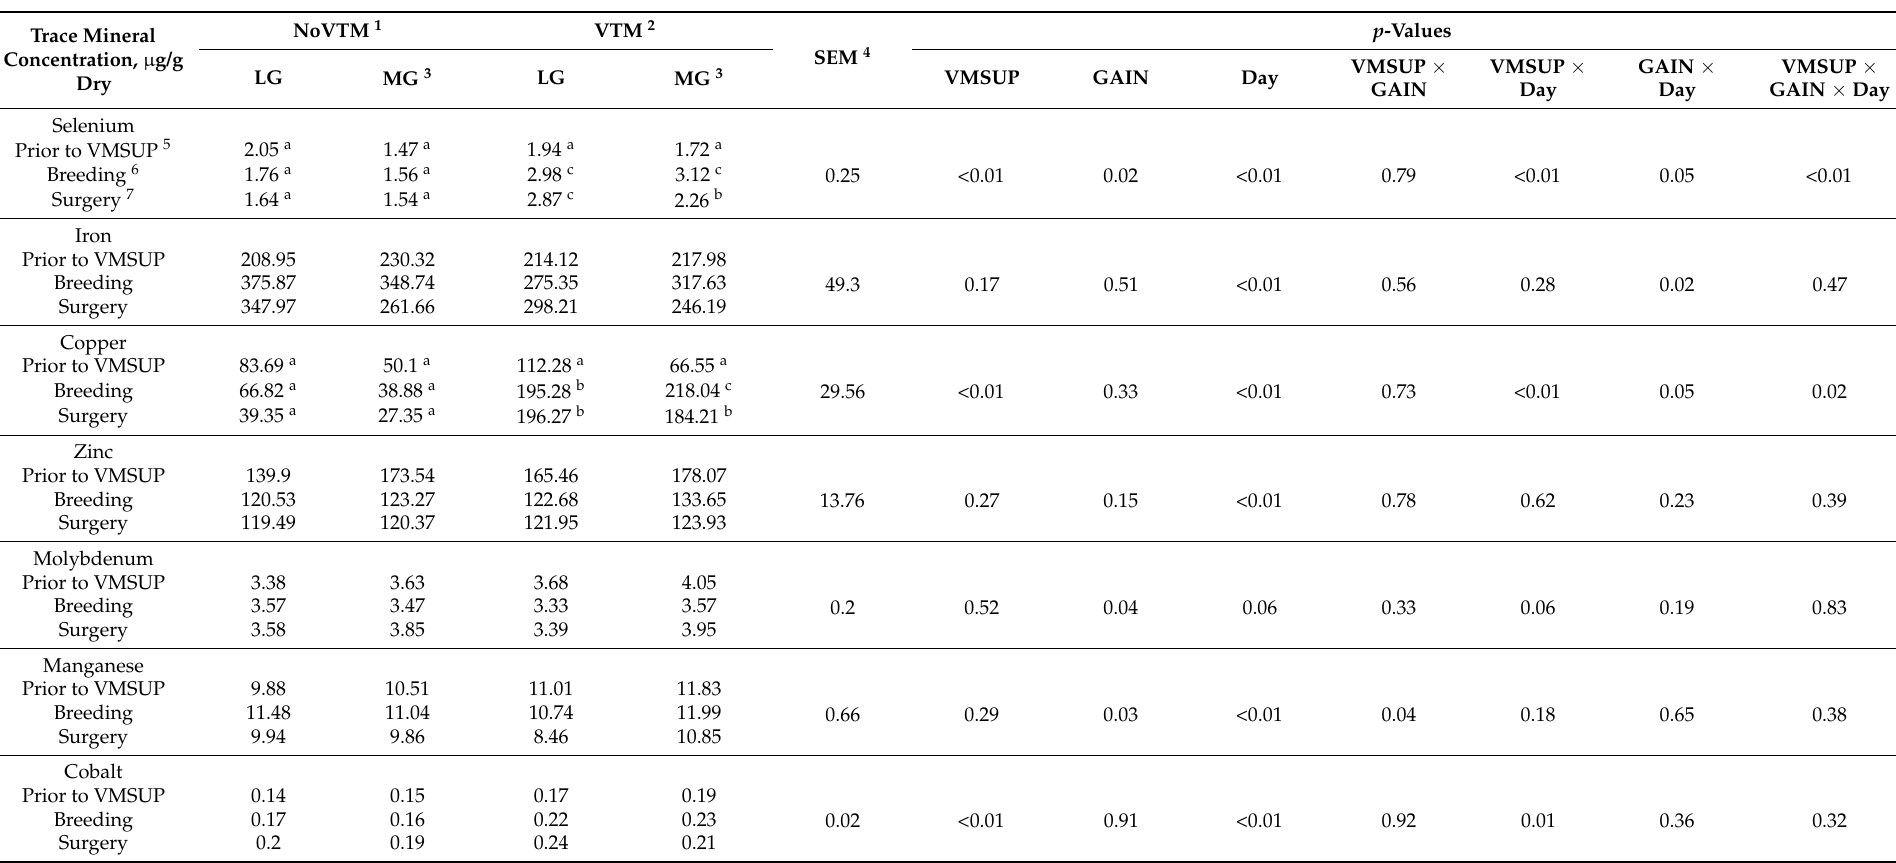
Table 4. Concentrations of trace minerals in maternal liver at three different time-points as influenced by maternal vitamin and mineral supplementation (VMSUP) and two different rates of gain (GAIN; low rate, 0.28 kg/d (LG) or moderate rate, 0.79 kg/d